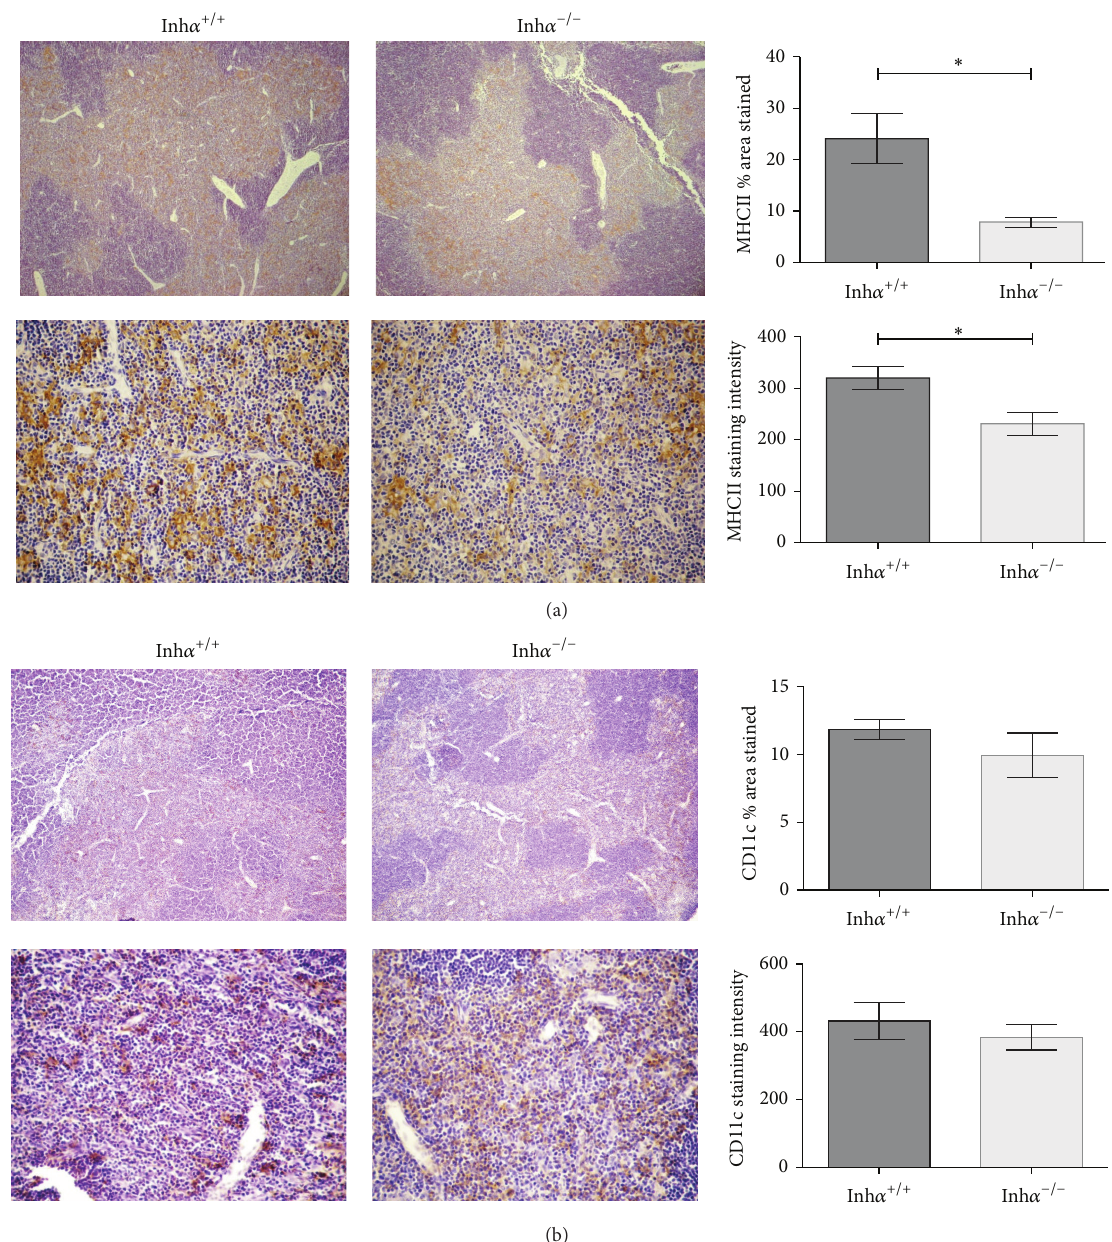
Figure 1: MHCII expression but not CD11c + cells is reduced in thymus of Inh 𝛼 −/− mice. Representative micrographs of thymic sections from 2-week-old Inh 𝛼 +/+ ( 𝑛 = 3 ) and Inh 𝛼 −/− ( 𝑛 = 6 ) mice stained for MHCII (a) and CD11c (b) are shown at 5x (top panels) and 40x (bottom panels) magnification. (a) MHCII staining and summary of data expressing the percentage of area stained per field (top, 𝑃 = 0.002 ) and the MHCII staining intensity (bottom, 𝑃 = 0.04 ) are shown. (b) CD11c staining and summary of data expressing the percentage of area stained per field (top) and the CD11c staining intensity (bottom). Values are expressed as mean ± SEM. Statistical significance: ∗ 𝑃 ≤ 0.05